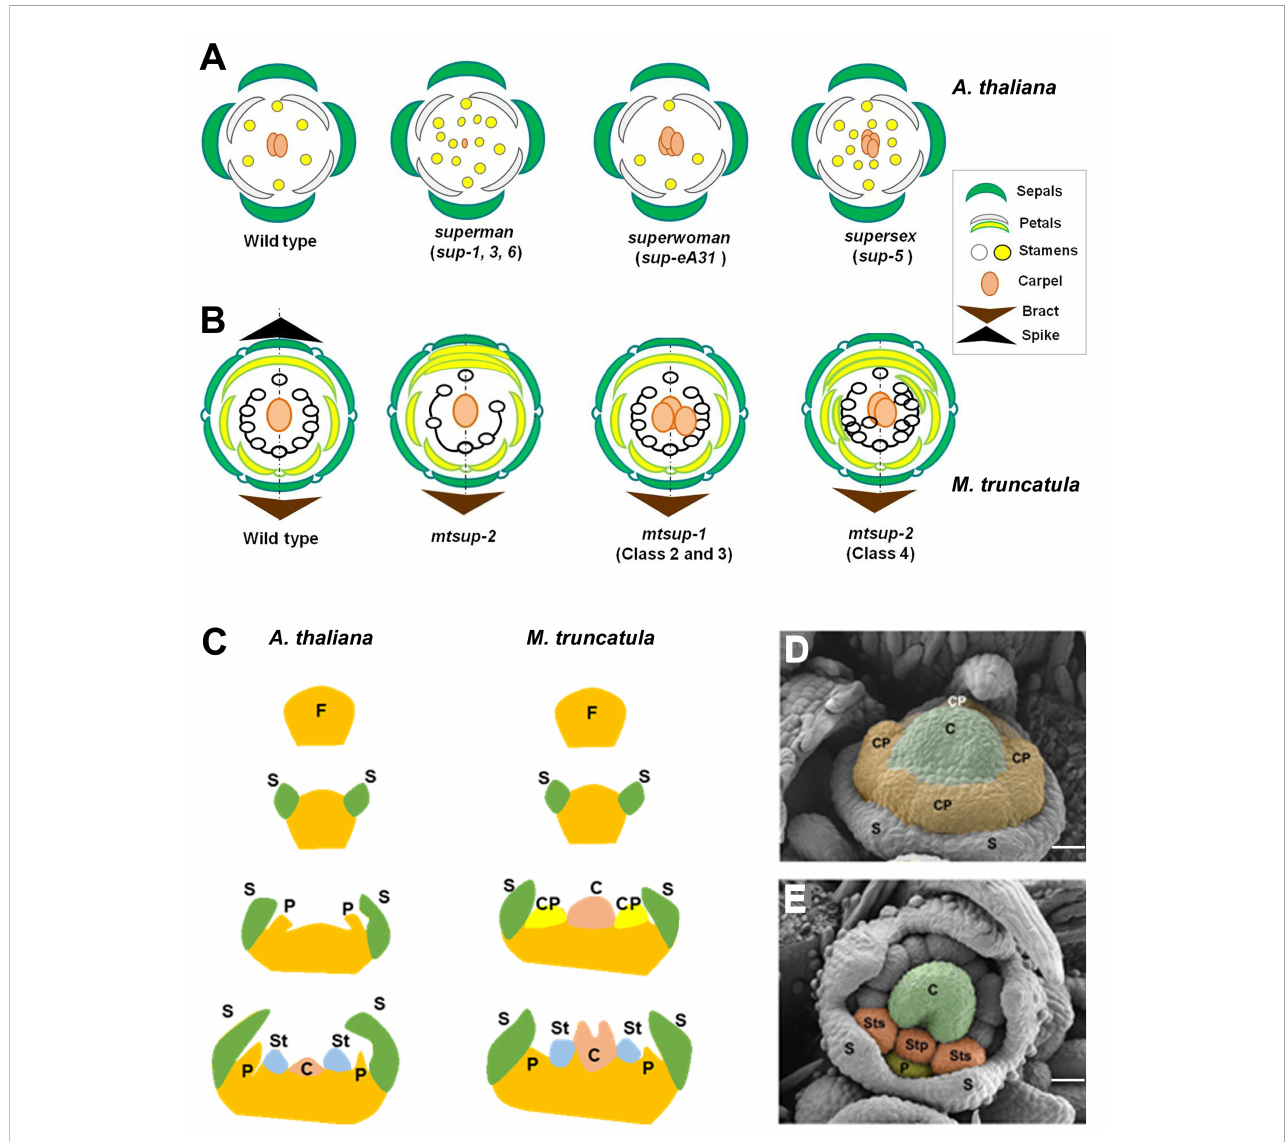
FIGURE 1 Comparative fl oral development of Arabidopsis thaliana and Medicago truncatula . (A) Comparative schematic representation among superman ( sup ) mutant alleles in Arabidopsis regarding fl oral organ number. Wild type A. thaliana fl ower: 4 sepals, 4 petals, 6 stamens and two fused carpels. (B) Comparative schematic representation among superman ( mtsup ) mutant alleles in Medicago regarding fl oral organ number. Wild type M. truncatula fl ower: 5 sepals, 5 petals, 10 stamens, 9 fused (staminal tube) and one free, and a single carpel. In Arabidopsis, the ‘ superman ’ class of mutants harbors supernumerary stamens and reduced or absent carpel, resembling mtsup-2 showing additional petals at the expense of stamens. An increased number of carpels characterize the “ superwoman ” class. Similar phenotypes displayed the mtsup-1 (class 2 and 3) alleles, with two or three carpels in M. truncatula. The “ supersex ” class, to which sup-5 allele belong, produces more stamens and additional carpels. This phenotype is observed in mtsup-1 allele (class 4). Also, additional petals are produced by this allele. (C) Left. In A . thaliana organ differentiation is centripetal and sequential. First are differentiated the sepal primordia, then the petal primordia, the stamen primordia and fi nally the carpel primordium. Right. In M. truncatula , the four common primordia differentiate petals and stamens in W2 and W3 respectively. (D) Floral meristem of M. truncatula showing the early carpel primordium (C, green) in the centre, the four common primordia (CP, orange) and the sepal primordia (S). (E) Each common primordium differentiates petals (P, yellow) in W2 and antepetal (Stp) and antesepal (Sts) stamens in W3 (orange). VM, vegetative meristem; FM, fl oral meristem; I1, primary in fl orescence meristem; I2, secondary in fl orescence meristem; spk, spike; S, sepal primordium; CP, common primordium; P, petal primordium; St, stamen primordium; C, carpel primordium. Scale bars, 25 m m in (D, E) Adapted from Benlloch et al., 2003; Breuil-Broyer et al., 2016; Prunet et al., 2017 and Rodas et al.,